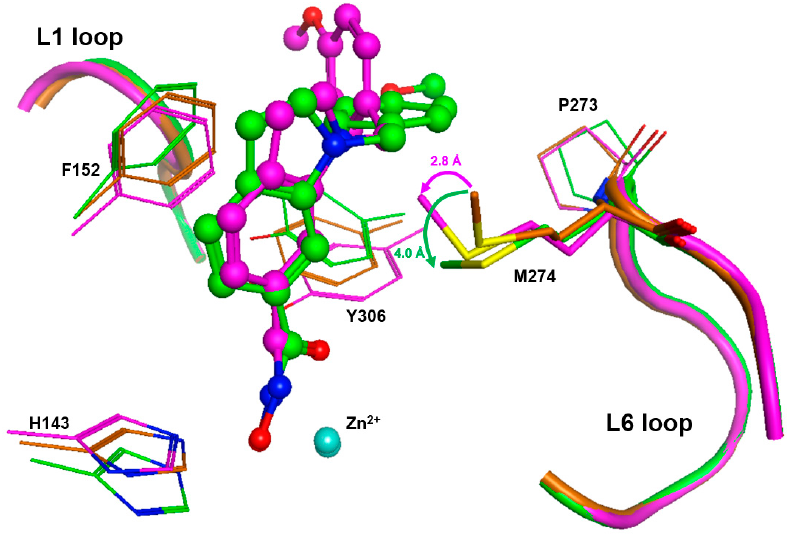
Figure 7. Close-up view of the binding pocket of human HDAC8. The unchanged conformation of HDAC8 (PDB-ID: 1T67, brown) is superimposed onto energy-minimized complex structures between HDAC8 (PDB-ID: 1T67) and PCI-34051 ligands (ball and sticks), with starting poses taken from tetrameric PDB-ID: 6HSF, chain A (green) and chain C (magenta). L1 and L6 loops are shown as tubes with the same color code. The catalytic zinc ions are displayed as cyan spheres. After some arrangement of the side chains of neighboring amino acids, PCI-34051 fits well into the selective HDAC8 pocket between Y306 and L1–L6 loops. Interestingly, the methyl group of M274 is not pushed away by the ligands, but is rather attracted, coming into proximity with the hydrophobic groups of the